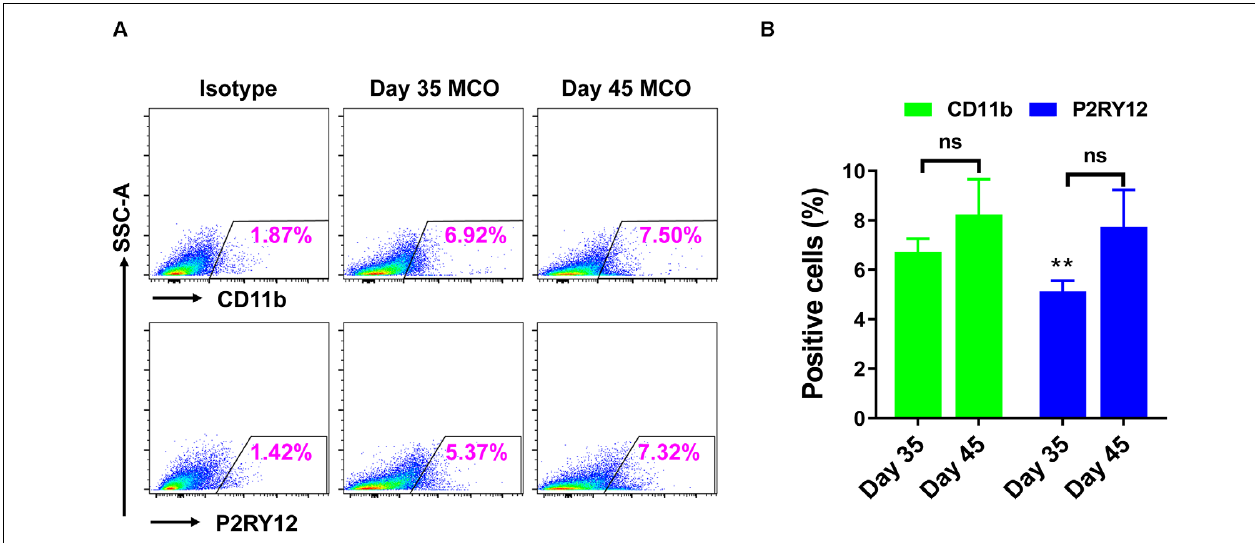
FIGURE 7 | Flow cytometry analysis identified the presence of microglia in iPSC-derived MCOs. The MCOs cultured for 35 and 45 days were subjected to flow cytometry analysis with CD11b and P2RY12. Isotype controls of the corresponding antibodies were used to determine the baseline expression of microglia marker. (A) Representative side scatter (SSC) images of one MCO. (B) Diagram graph showing the average percentage of positive cells per MCO. Data represent mean ± SE of three MCOs per group. The ** P < 0.01 indicates the significant difference from corresponding marker CD11b at day 35. The ns indicates no significance statistically as compared with corresponding day 35 in each